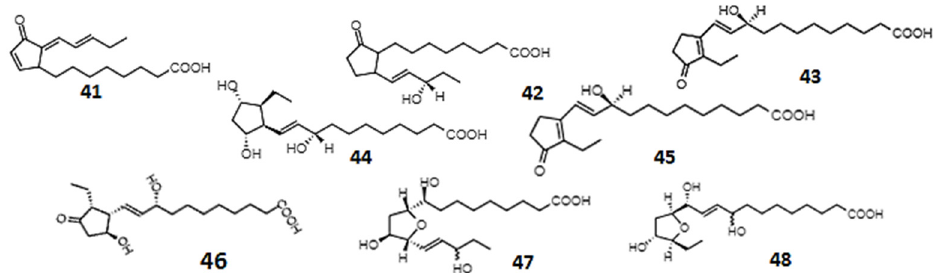
Figure 6. Chemical structures of phytoprostanes and phytofurans: deoxy-J1-PhytoP ( 41 ); 16-B1-PhytoP ( 42 ); 9-L1-PhytoP ( 43 ); 9- epi -9-F1t-PhytoP ( 44 ); ent-16-epi-16-F1t-PhytoP ( 45 ); 9-epi-9-D1t-PhytoP ( 46 ); ent-16(RS)-9-epi-ST Δ 14-13-PhytoF ( 47 ); and ent-9(RS)-12-epi-ST-9- Δ 10-13-PhytoF ( 48 ). Some oxylipins, such as phytoprostanes, 12-OPDA ( 2 ), acrolein, 2-hexenal ( 7 ), and